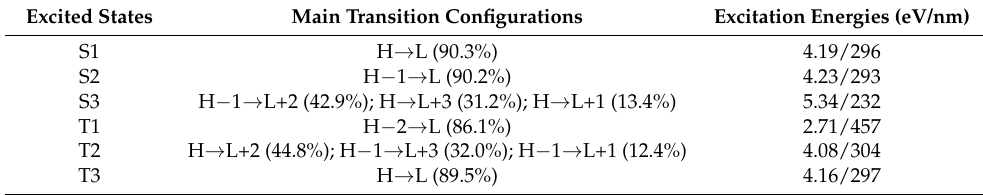
Table 2. The calculated three singlet and triplet excitation energies (eV), wavelength (nm), and